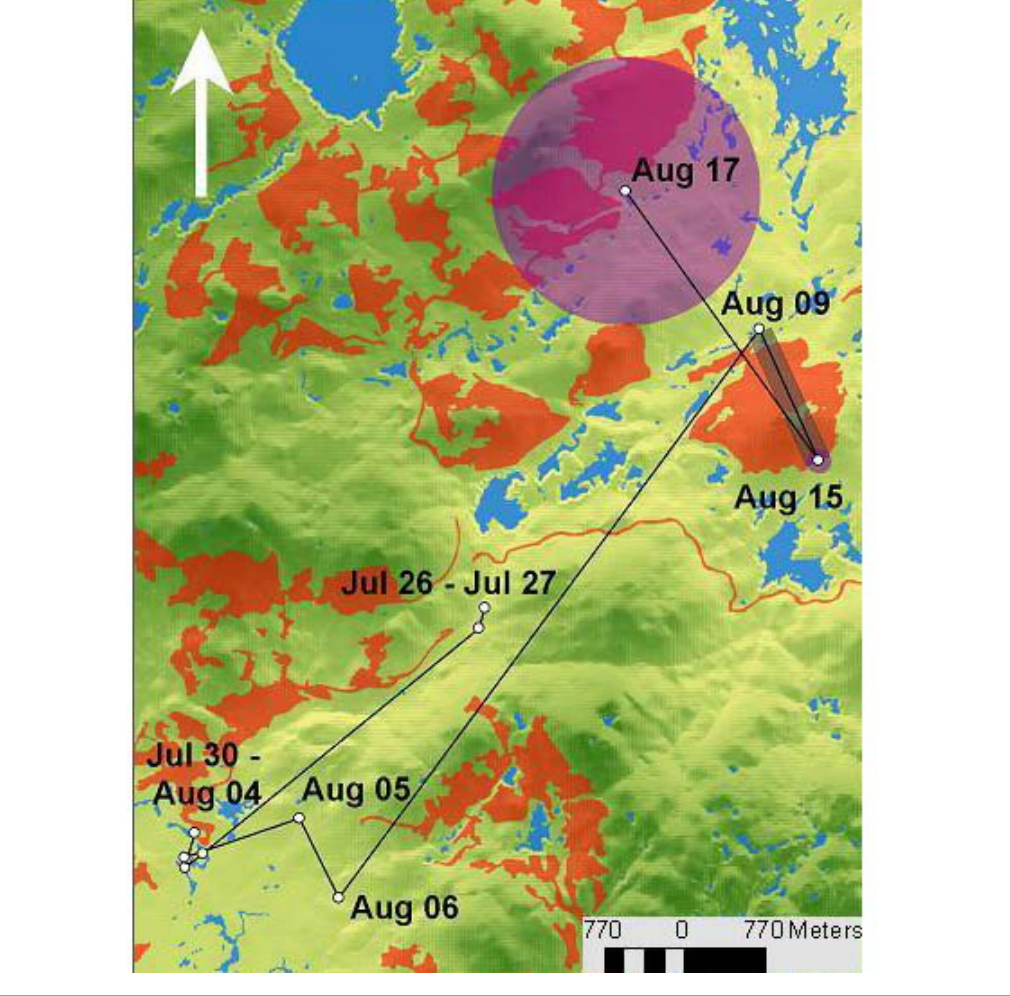
Fig. 2. Digital elevation model and movement track for a Blackpoll Warbler originally captured at the southern-most study site. White circles represent individual locations at specific dates. Sequential locations have been connected using black lines. Green and yellow areas represent high and low elevation habitat, respectively. Red areas represent clearcut land cover and blue areas represent lakes as well as first- and second-order rivers. The small and large purple circles buffering points at 15 August and 18 August represent examples of neighborhood and landscape buffers, respectively. The gray rectangle located between locations at 09 August and 15 August is an example of a buffer that was used to quantify clearcut land cover between sequential locations for the assessment of landscape connectivity. North is located at the top of the map (depicted by the white